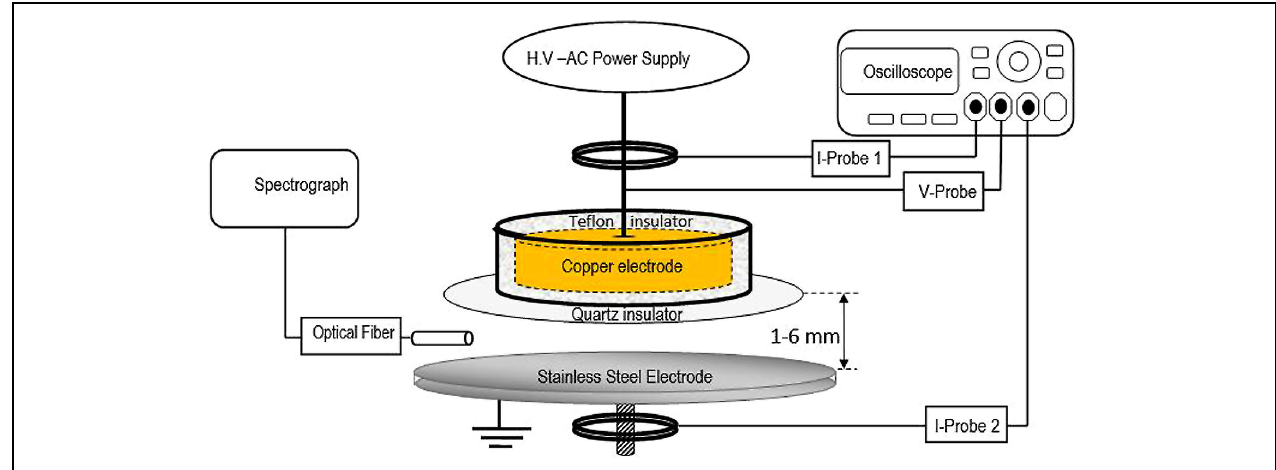
FIGURE 1 | Schematic diagram of experimental set up of atmospheric pressure dielectric barrier discharge (DBD) plasma in